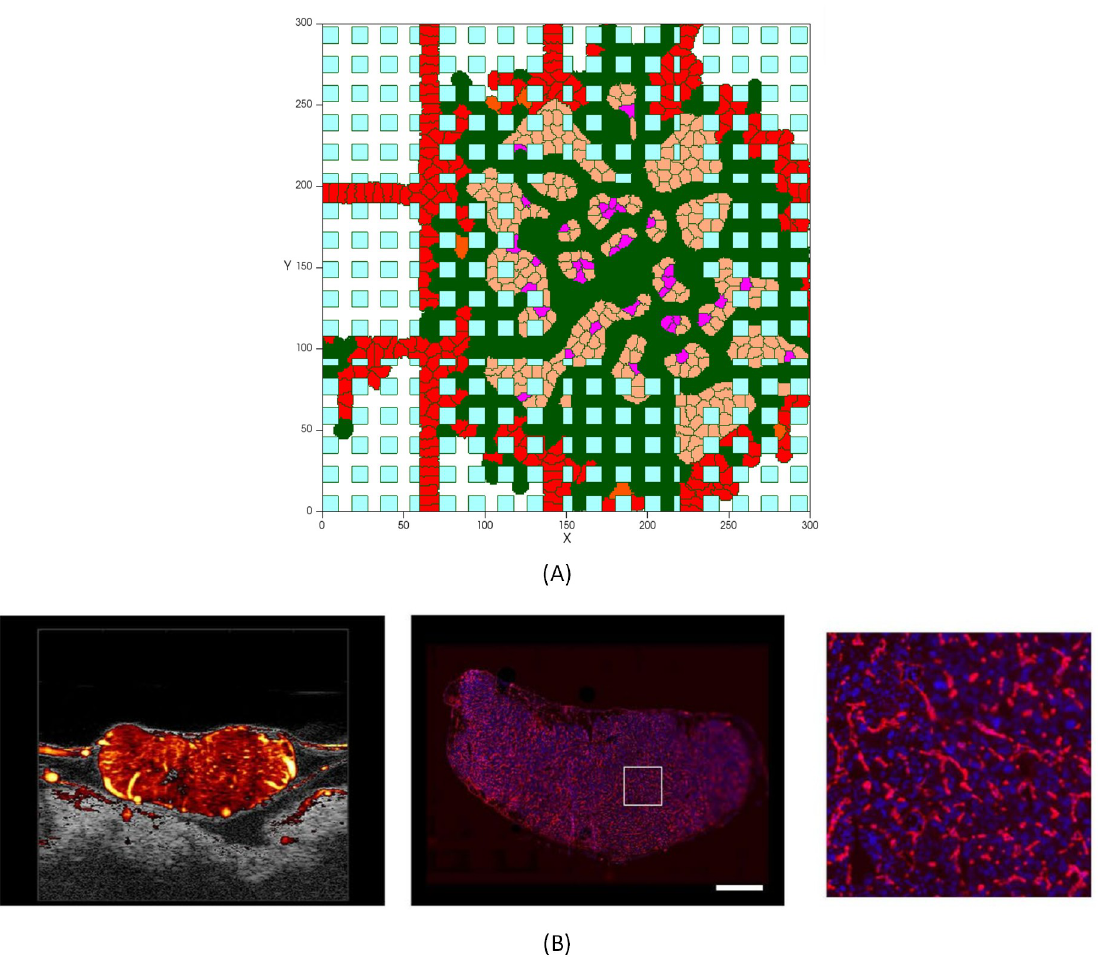
Fig 14. Tumor with a dense capillary network. (A) Simulation results of a high vascularized tumor, with a similar vasculature profile as the experimental image of the network in a tumor [128], (B) Left: Ultrasound Microvessel Imaging; center: fluorescent histology of vessel area around viable tumor cells (scale bar is 1mm); right: enlargement of square area from previous image [128].